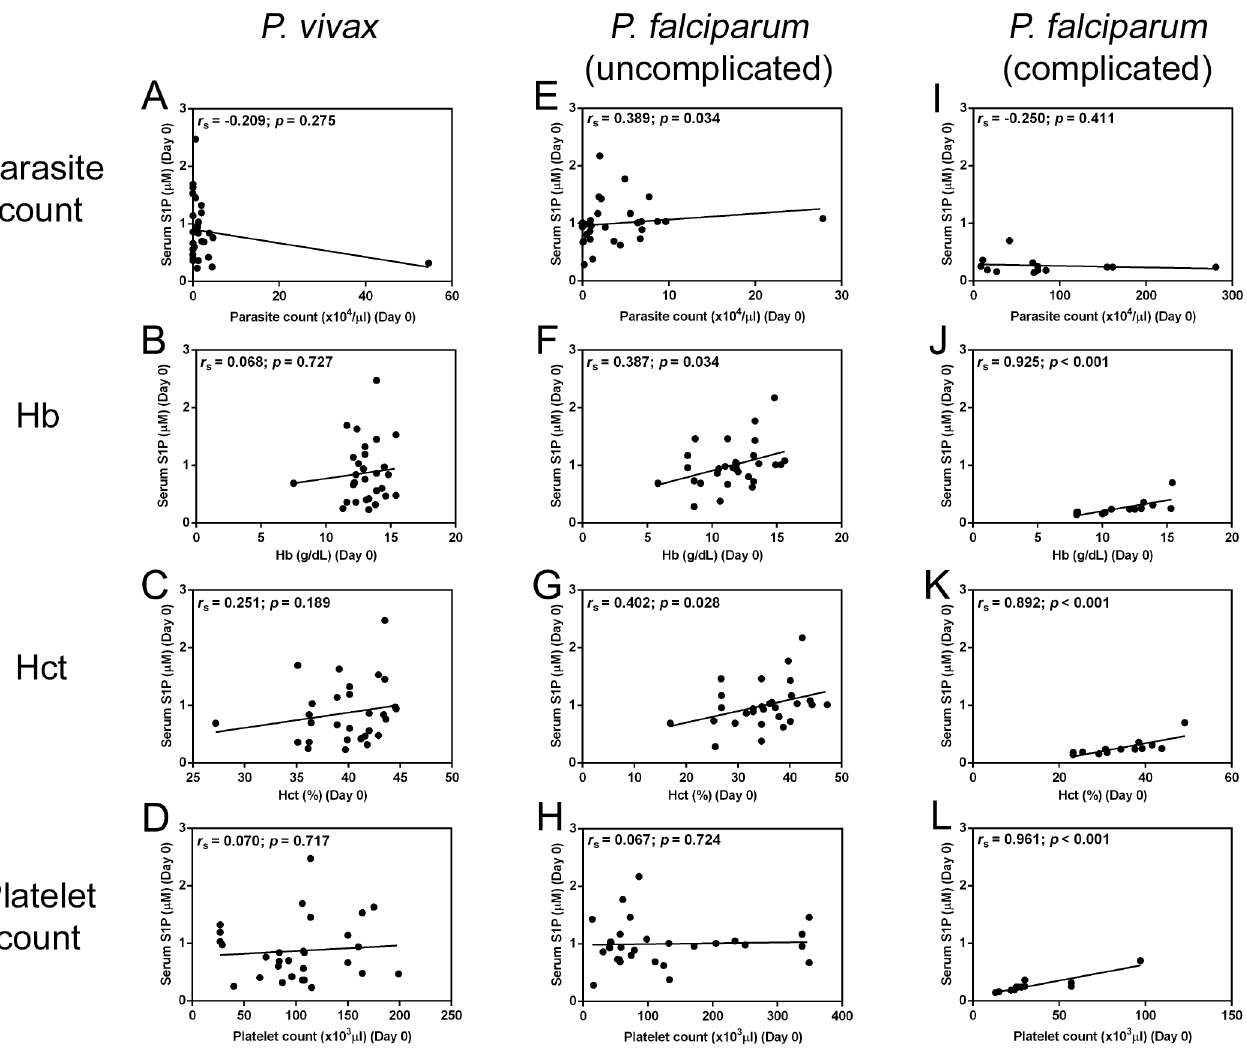
Fig 3. Correlation of serum S1P on admission with parasite count, hemoglobin (Hb), hematocrit (Hct) and platelet count in P . vivax (A-D), uncomplicated P . falciparum (E-H) and complicated P . falciparum (I-L) malaria patients. Data analyzedby Spearman’s rank correlation.